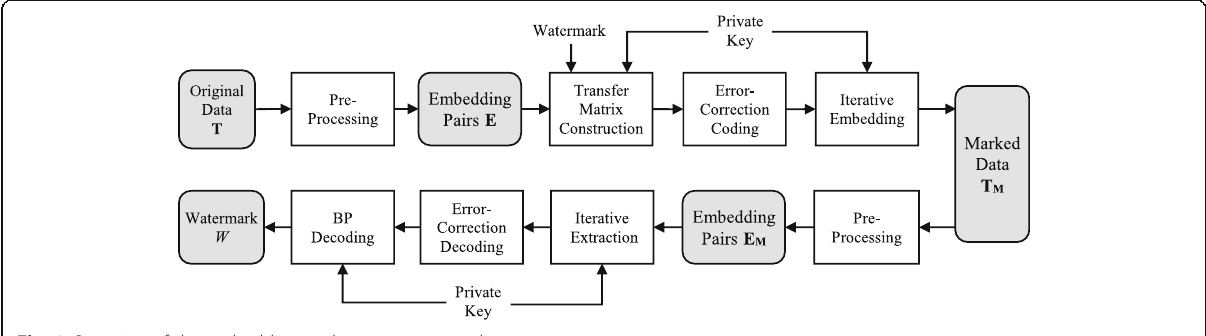
Fig. 2 Overview of the embedding and extraction procedure